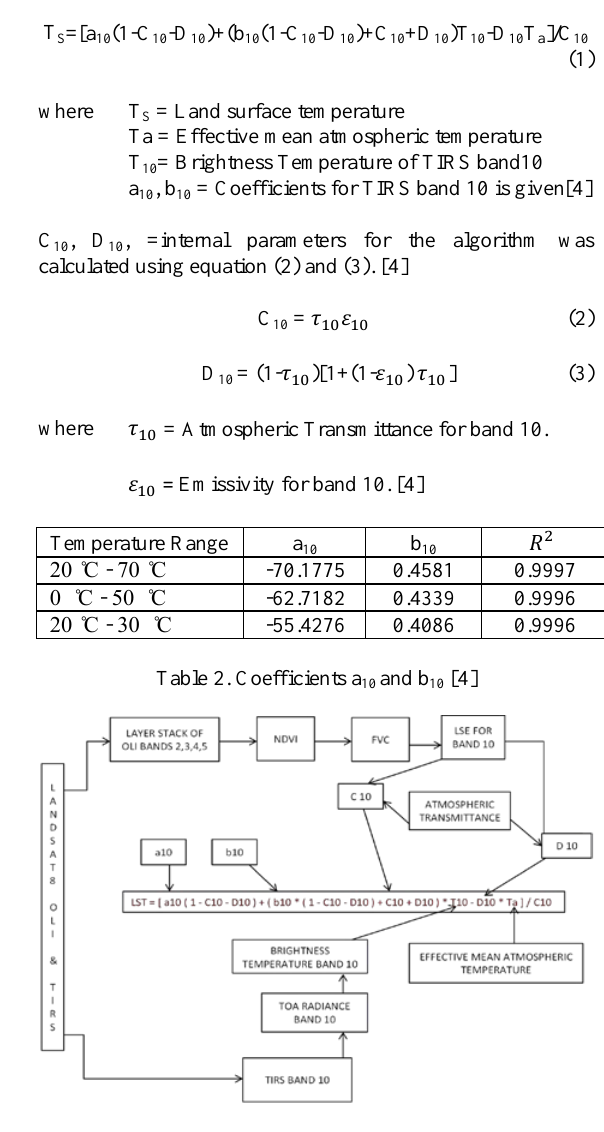
Figure 2: Flowchart of Mono-window